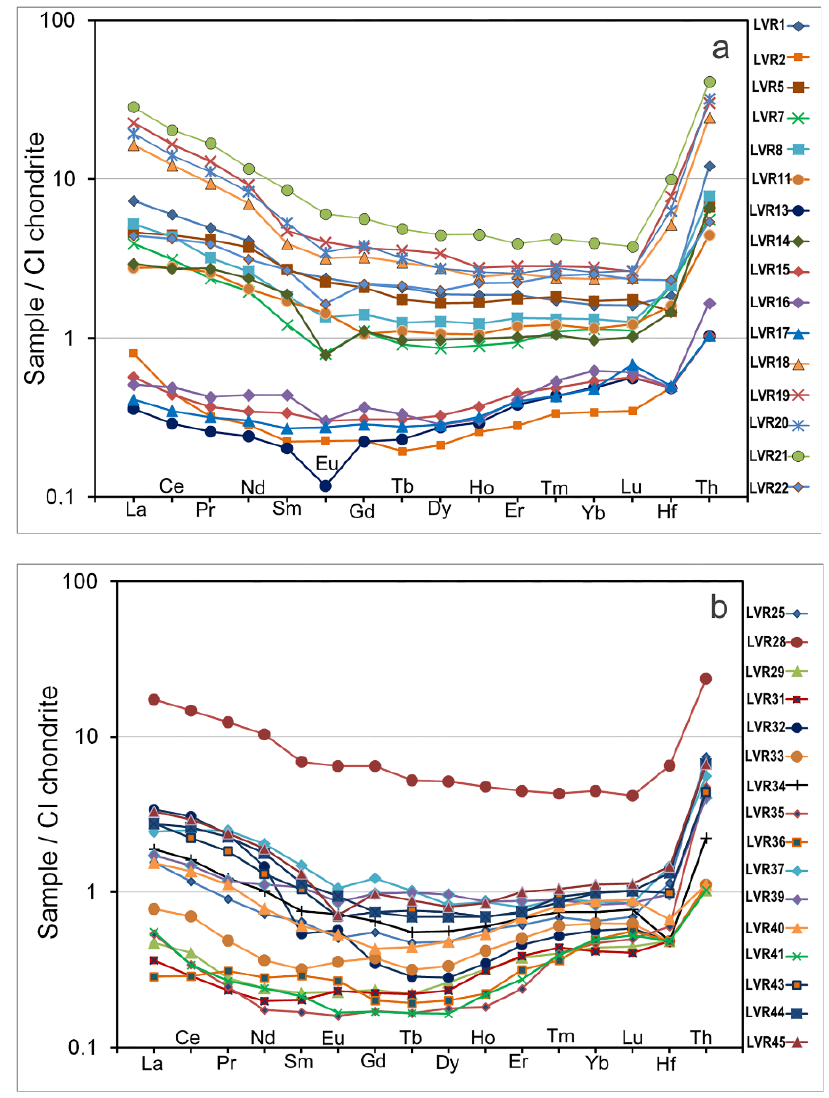
Figure 17. ( a , b ). The CI–chondrite-normalized contents of lanthanides, Hf and Th [41] in the ultrabasic rocks of the Lyavaraka complex. As indicated in the caption to Figure 2, samples LVR29–35 constitute Zone I, LVR1–17, 22–25 and 36–45 are in Zone II, with LVR26 located close to the boundary with Zone I, and samples LVR18–20, 21, 27 and 28 belong to Zone III.